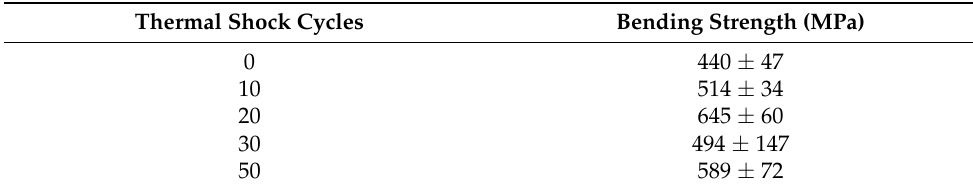
Table 4. Relationships between thermal shock cycles and residual strength